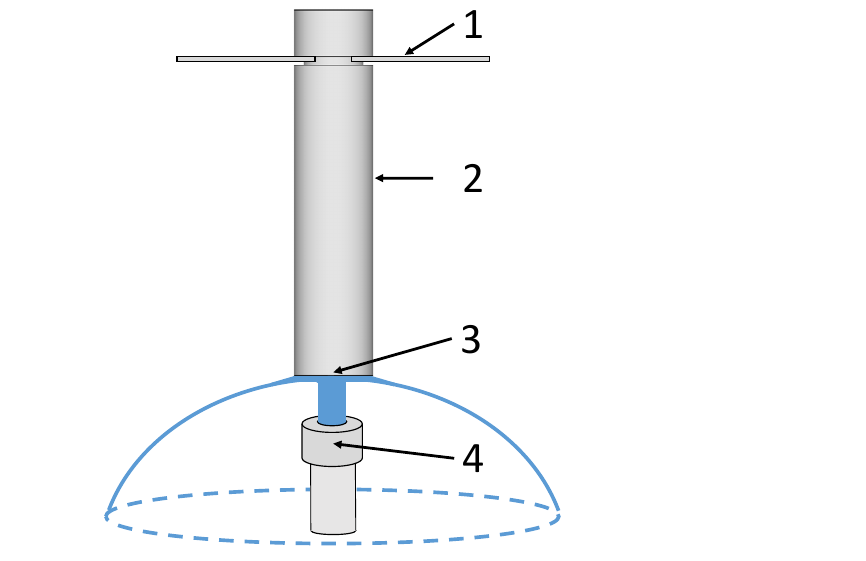
Figure 2. Schematic illustration of the Jominy end quench device based on [16]. (1) Mounting fixture, (2) Jominy test specimen, (3) end face of the test specimen quenched with water, and (4) water spray